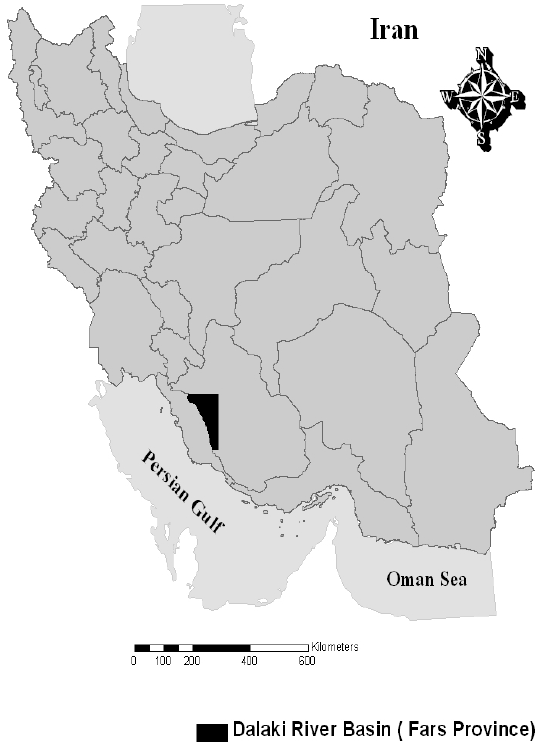
Fig. 1. The geographical location of Dalaki watershed